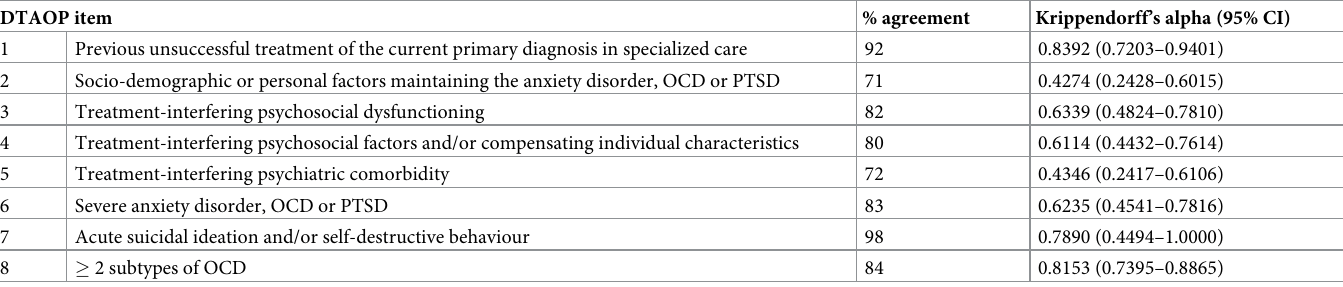
Table 4. Inter-rater reliability indices as assessed by percent agreement and Krippendorff’s alpha (n = 87). DTAOP item %